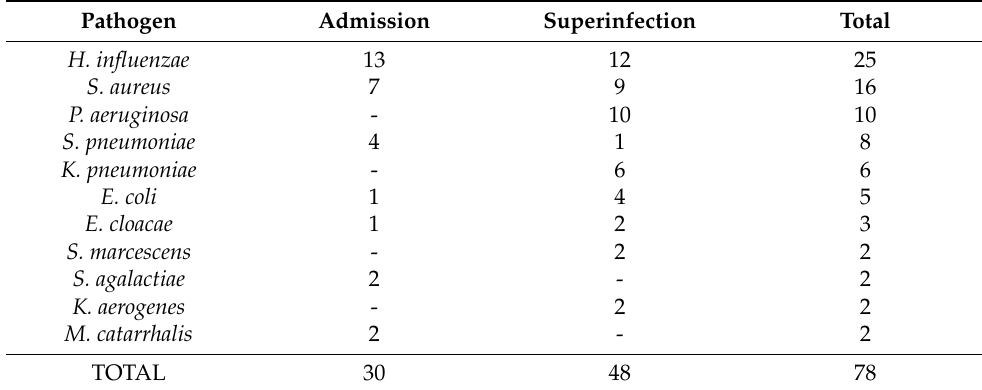
Table 3. Distribution of pathogens detected at the moment of admission and in cases of superinfection. Pathogen